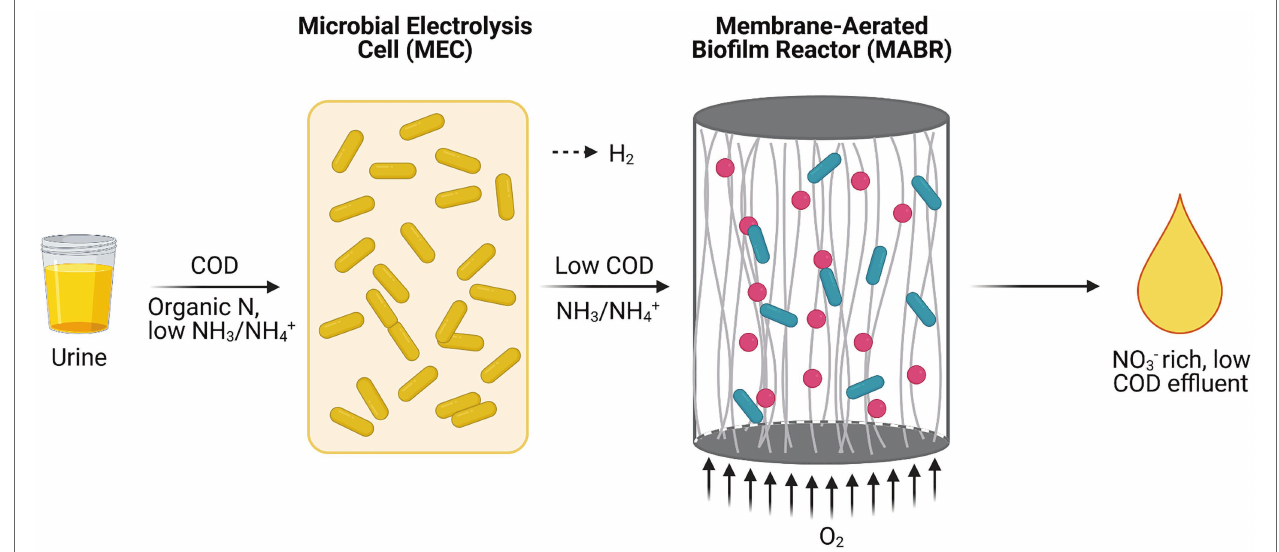
FIGURE 5 | Schematic representation of a microbial electrolysis cell (MEC) and a membrane-aerated biofilm reactor (MABR) in a serial setup (Adapted from De Paepe et al.,